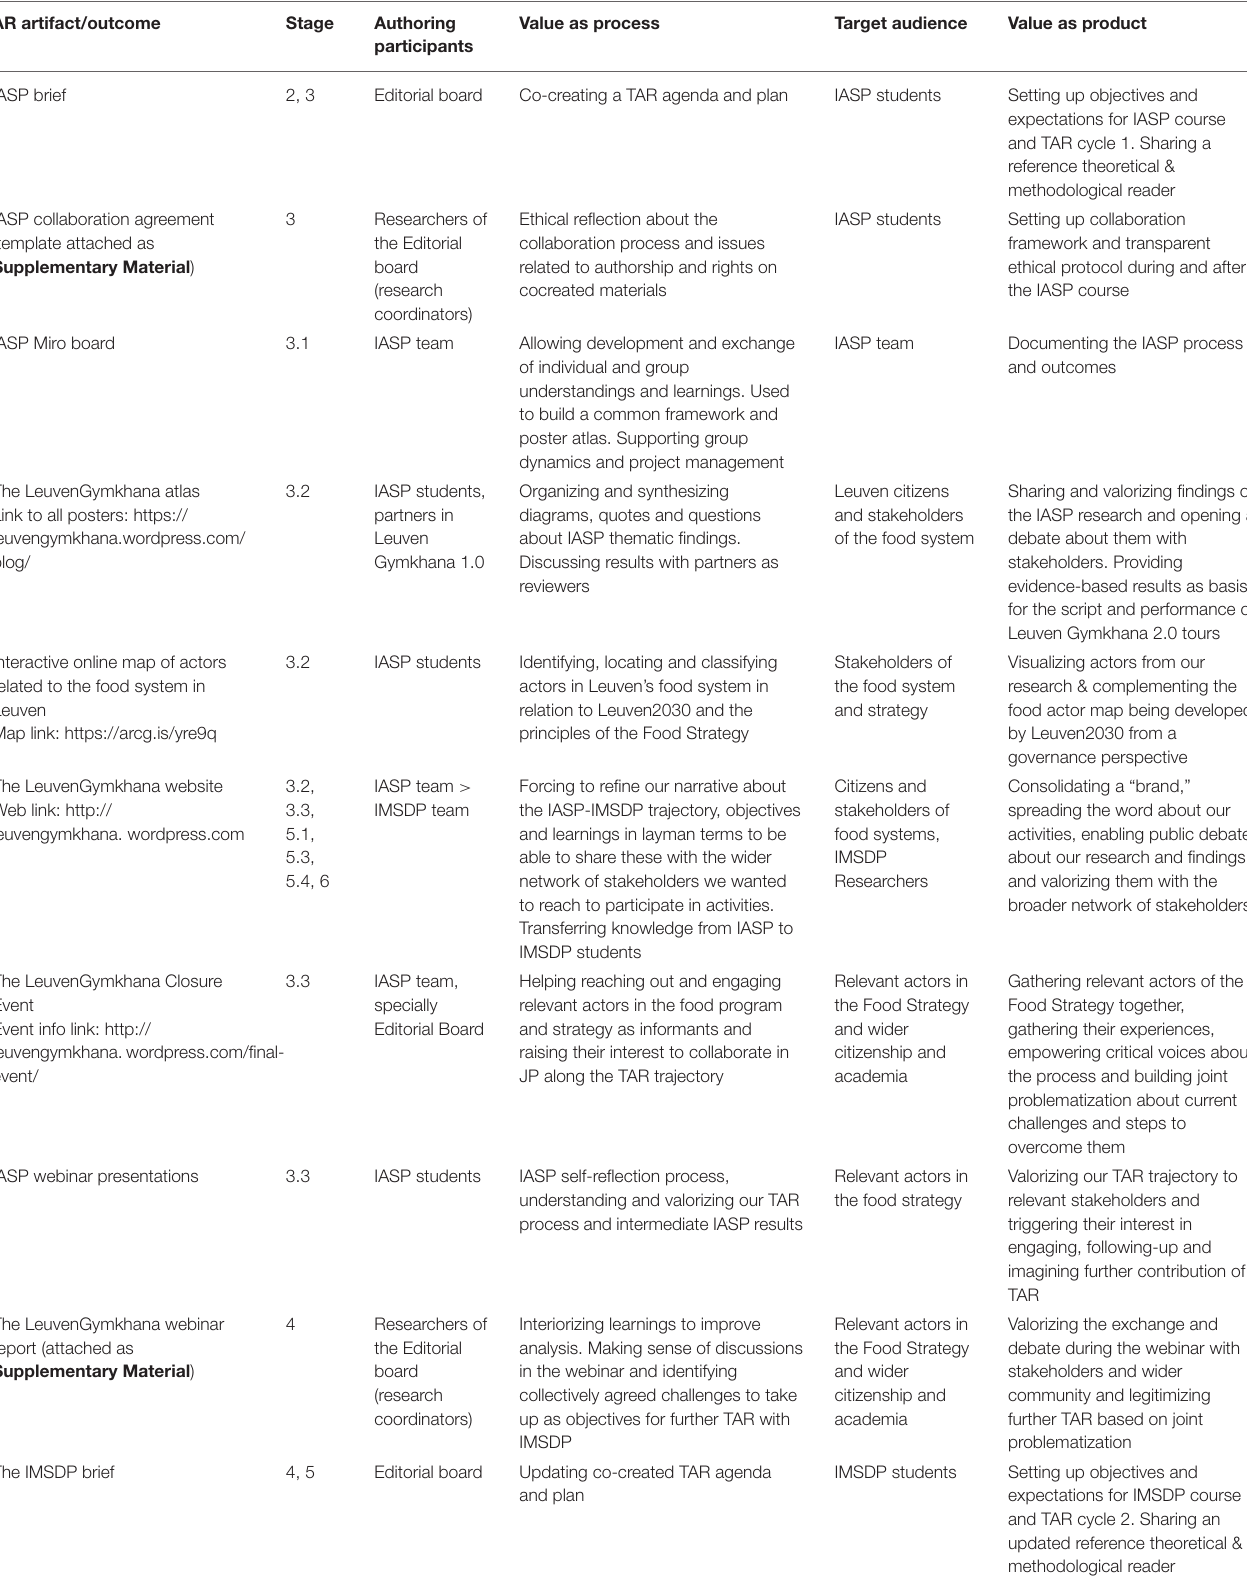
TABLE 2 | List of AR artifacts and outcomes cocreated along the process, reflecting on their role as “process” and as